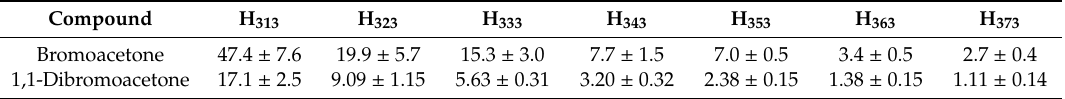
Table 3. Henry’s Law constants, H T (M atm − 1 ), determined for di ff erent temperatures, T (K), based on the partitioning coe ffi cients measured by the vapor-phase chromatographie (VPC)